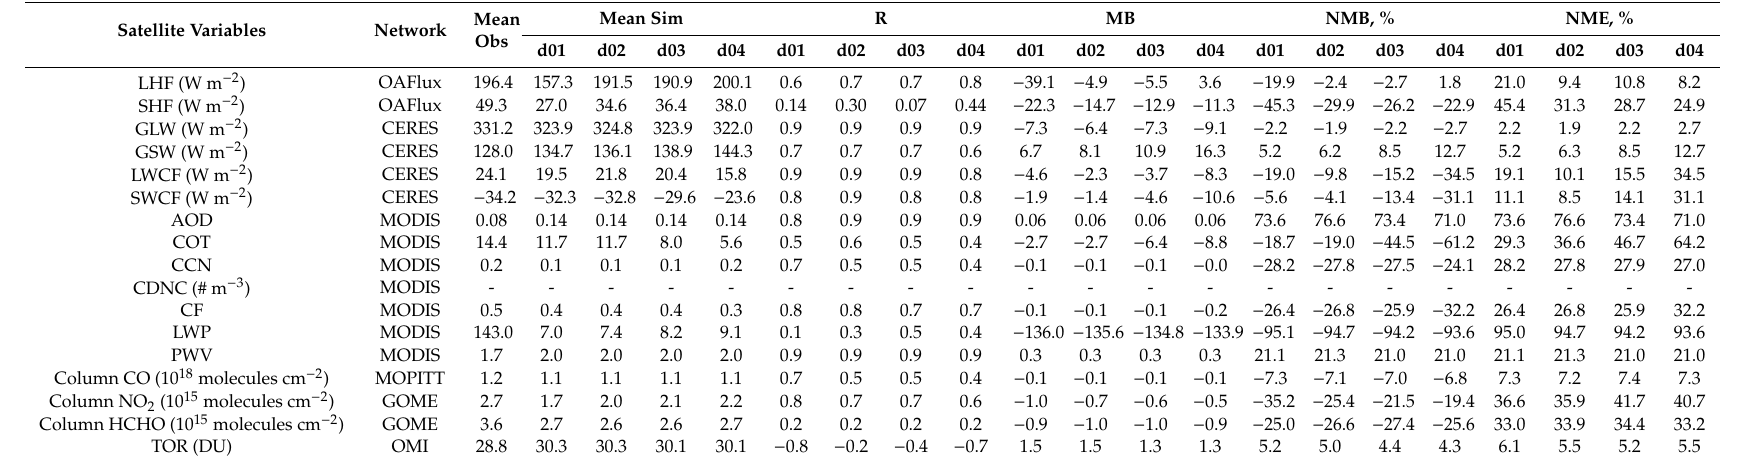
Table 5. Performance statistics of radiative, cloud, heat flux, and column gas variables from WRF / Chem-ROMS simulations at a horizontal grid resolution of 81-km (in d01), 27-km (in d02), 9-km (in d03), and 3-km (in d04) calculated using predictions and observations in d04 for the SPS2 field